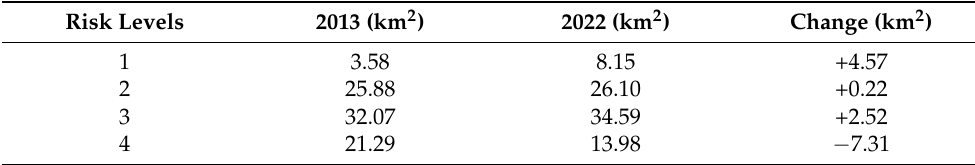
Table 8. Tsunami risk change from 2013 to 2022. Risk